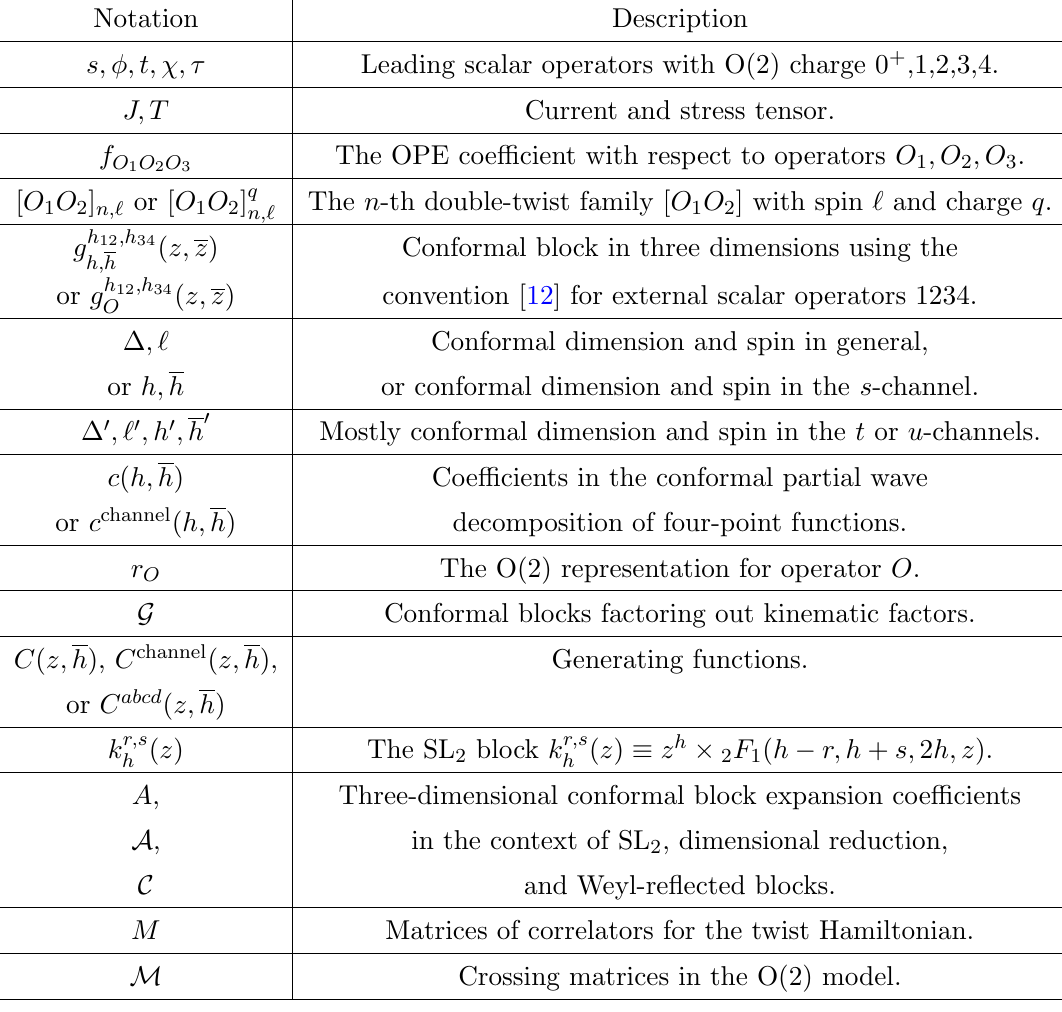
Table 8 . Some of the notation used in this